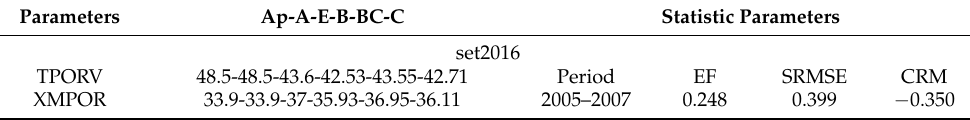
Table 6. Soil parameter sets for calibration and goodness-of-fit